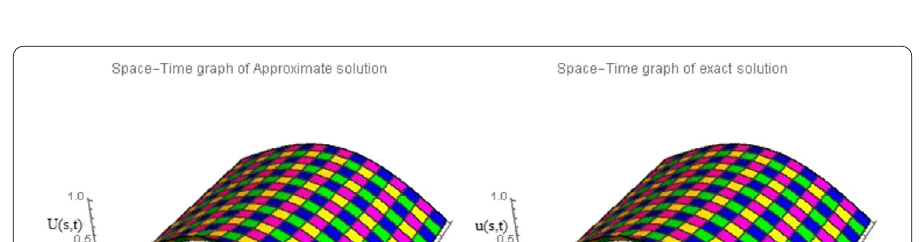
Figure 3 The exact (right) and numerical (left) solutions when τ = 0.001, h = π